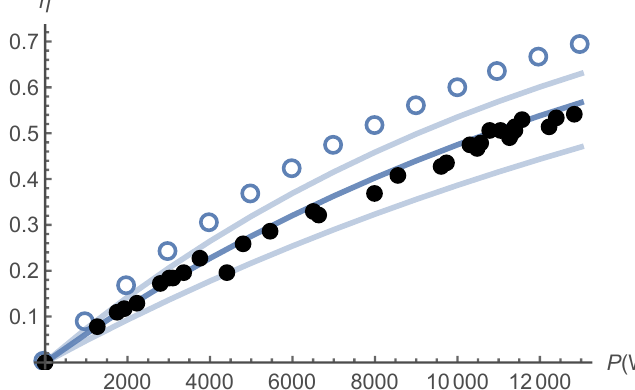
Figure 5. Photodetachment ratio η , measured as the attenuation of the negative ion beam when the laser is switched on, as a function of the intracavity power P . The black dots are the experimental points. The continuous lines correspond to what can be predicted by theory, for a 3.6 × 10 − 21 m 2 cross-section and three different hypotheses for the offset δ of the two laser beams, the one with respect to the other, in the direction perpendicular to the ion beam: zero, 250 and 400 µ m, from top to bottom, respectively. The open circles show the photodetachment ratios that would be obtained for twice heavier, hence √ (cid:35) 2 times slower D − ions, for the most probable δ = 250 µ m